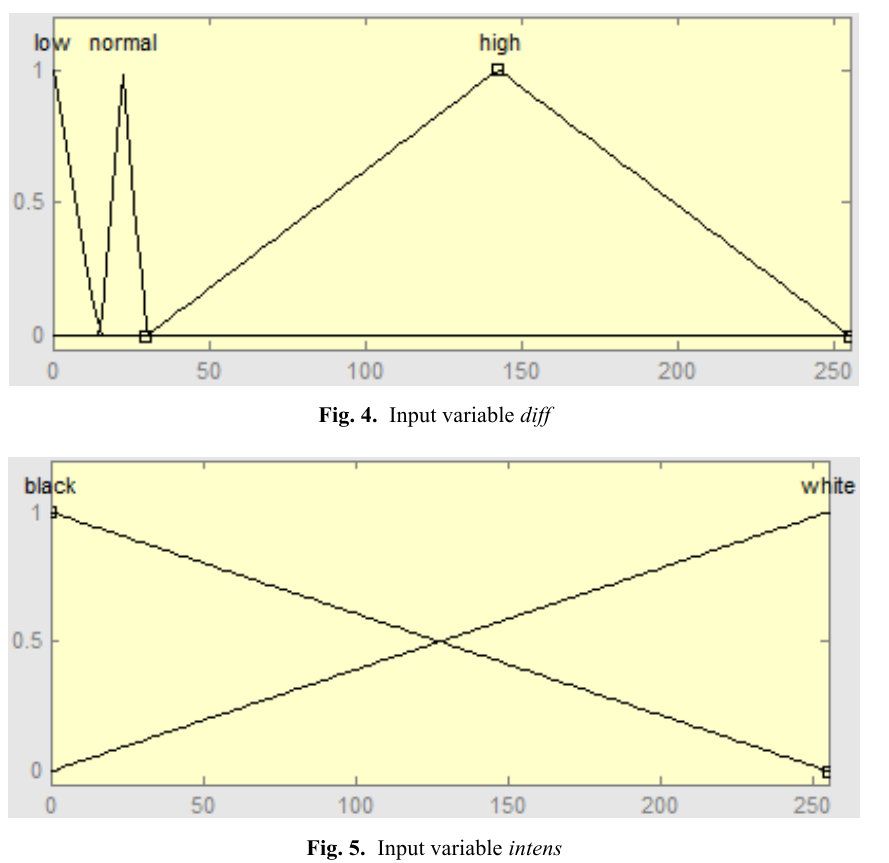
Fig. 5. Input variable